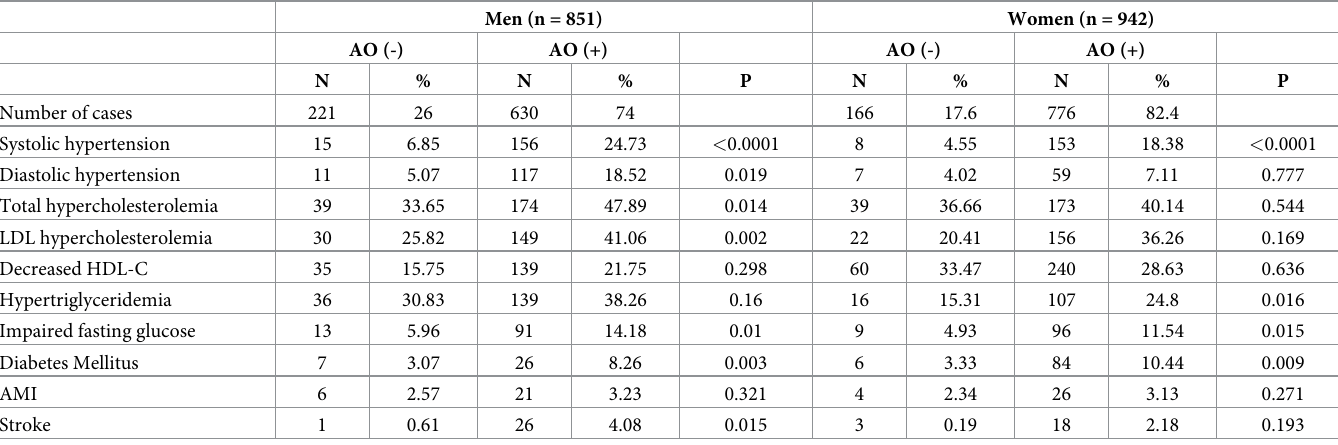
Table 4. Frequency of CVRF, AMI and stroke in overweight individuals (BMI: 25–29.99 kg/m 2 ) with AO defined by lower WC cutoff values.